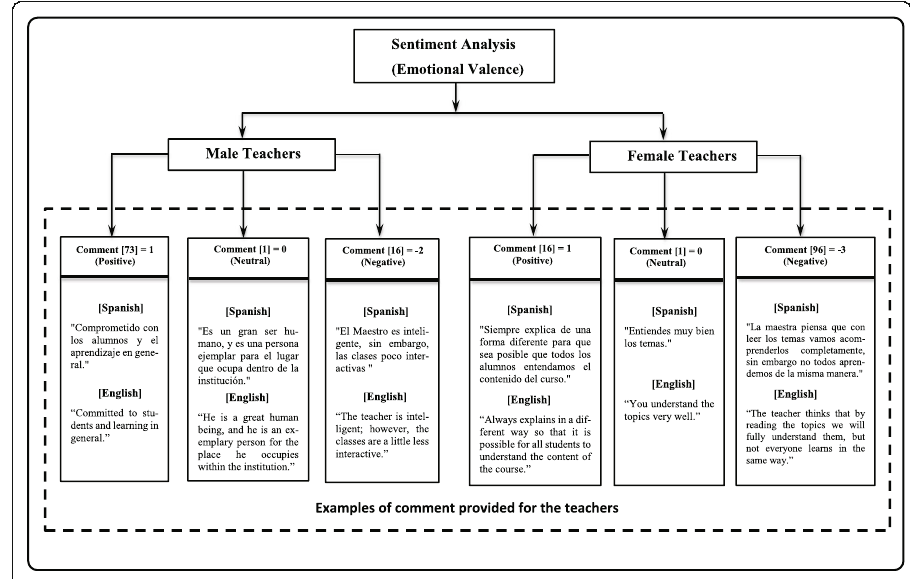
Fig. 8 Sentiments analysis and outcomes of the EPDM model for the Teachers